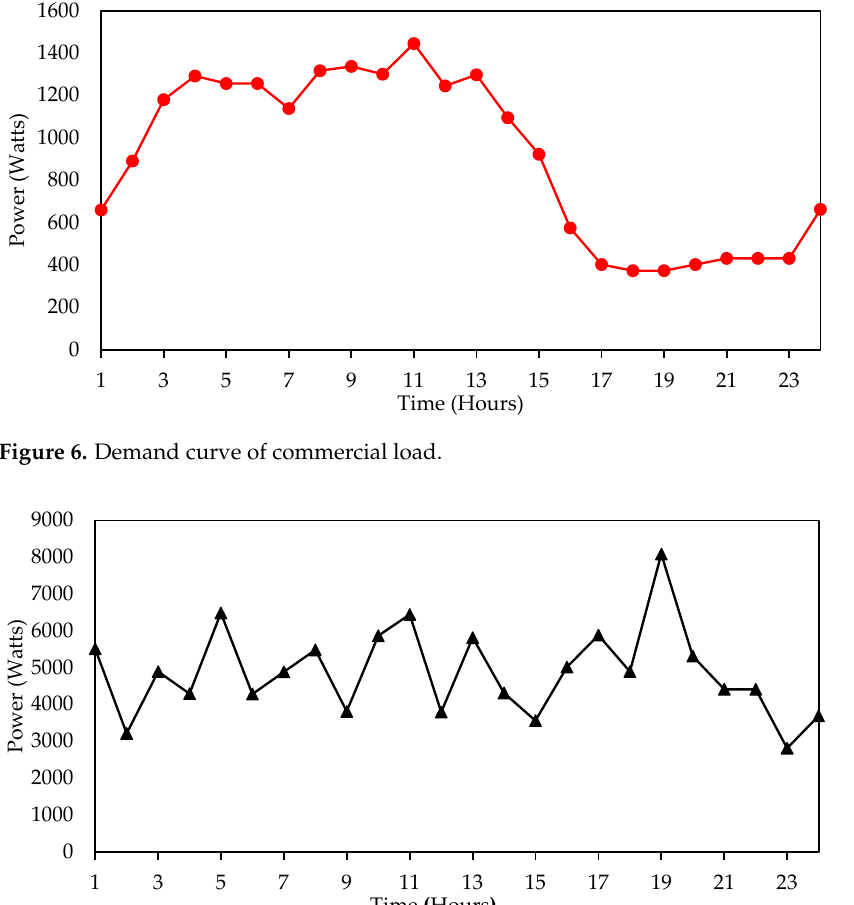
Figure 5. Demand curve of residential load.